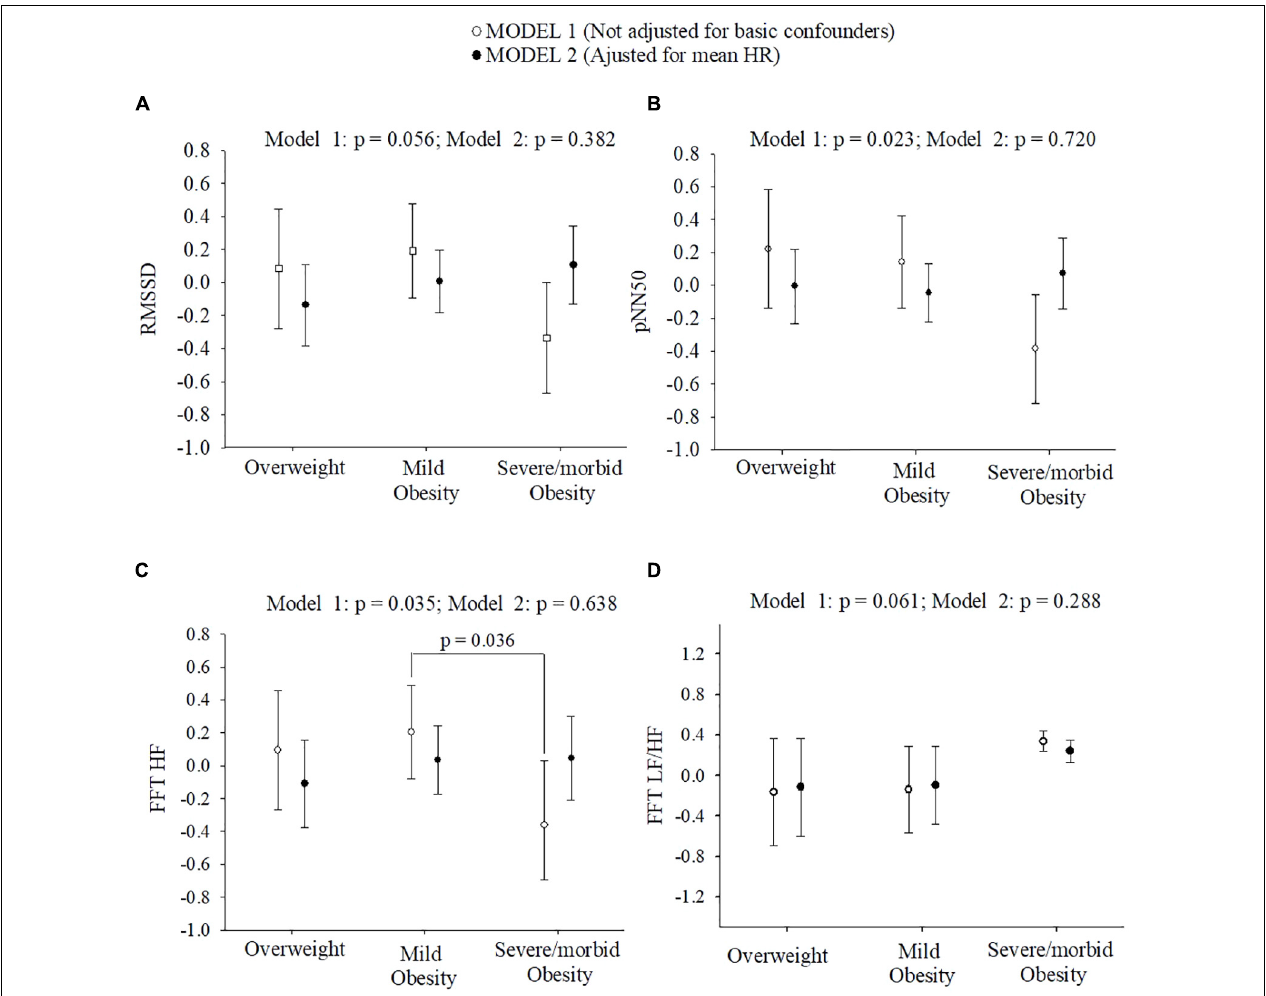
FIGURE 1 | Normal scores of HRV parameters in time and frequency-domain across children with overweight/obesity. (A,B) show differences of HRV parameters in time-domain across children with overweight/obesity. (C,D) show differences of HRV parameters in frequency-domain across children with overweight/obesity. Adjusted means and 95% confidence intervals are presented. Bonferroni post hoc analysis did not show significant differences for pNN50 across children with different weight status. See full name of all the heart rate variability parameters in Table 1